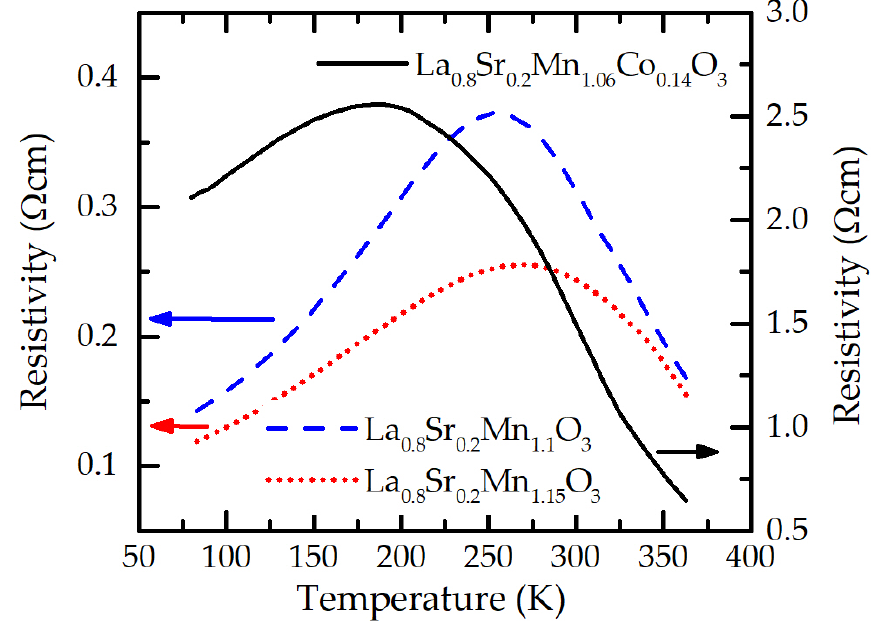
Figure 2. Resistivity vs. temperature dependences of LSMO and LSMCO films with different Mn and Co contents.